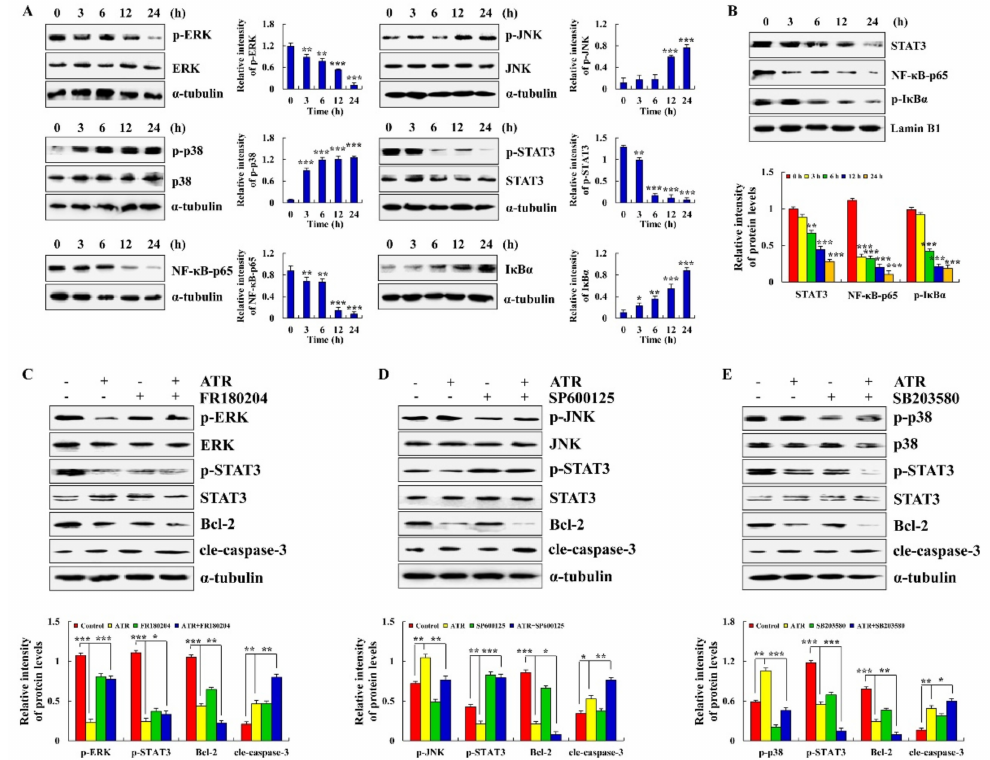
Figure 3. Effects of ATR on MAPK, STAT3, and NF- κ B signaling pathways. A549 cells treated with 38 µ M ATR for 3, 6, 12, and 24 h. ( A ) Expression levels of MAPK, STAT3, and NF- κ B signaling pathway-related proteins detected by Western blot analysis. ( B ) Expression levels of nuclear proteins STAT3, NF- κ B-p65, and p-I κ B α . * p < 0.05, ** p < 0.01 and *** p < 0.001 vs. 0 h. A549 cells